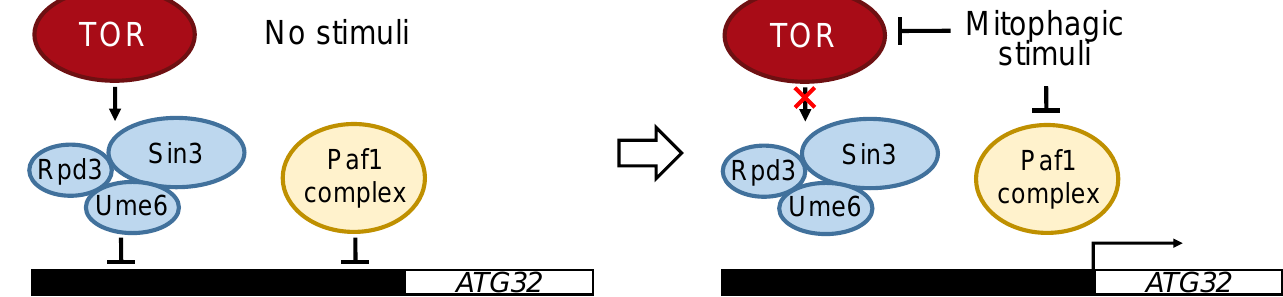
Figure 3. Regulation of ATG32 transcription. In nutrient-rich conditions, transcription of ATG32 is inhibited by Ume6–Sin3- Rpd3, which is regulated under TOR. The transcription of ATG32 is also inhibited by the polymerase-associated factor 1 (Paf1) complex. Both the Ume6–Sin3-Rpd3 and Paf1 complexes directly bind to the promoter region of ATG32 to inhibit the transcription of ATG32 . Mitophagic stimuli, such as nitrogen starvation, inhibits TOR and releases Ume6–Sin3-Rpd3 and Paf1 complexes from the promoter region of ATG32 to allow the transcription of ATG32